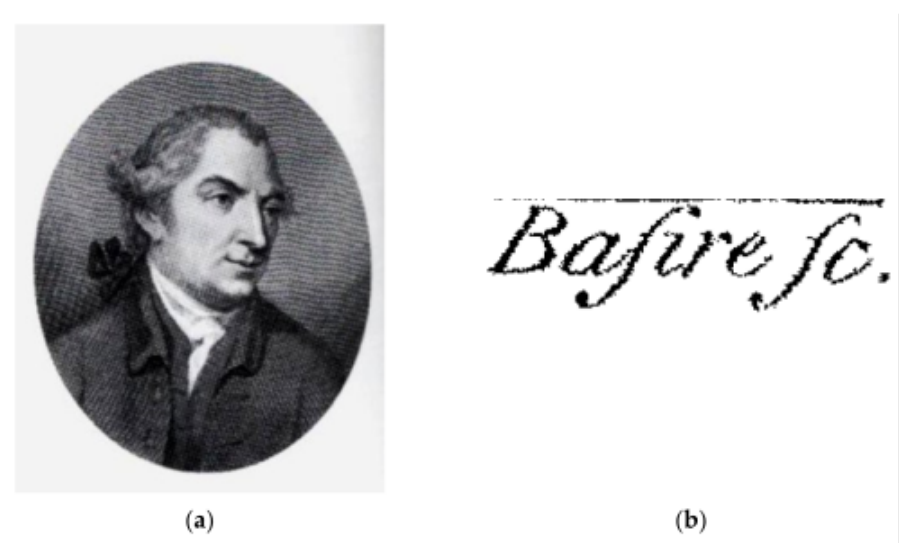
Figure 12. ( a ) James Basire [16] and ( b ) his signature on all graphics in Herschel’s